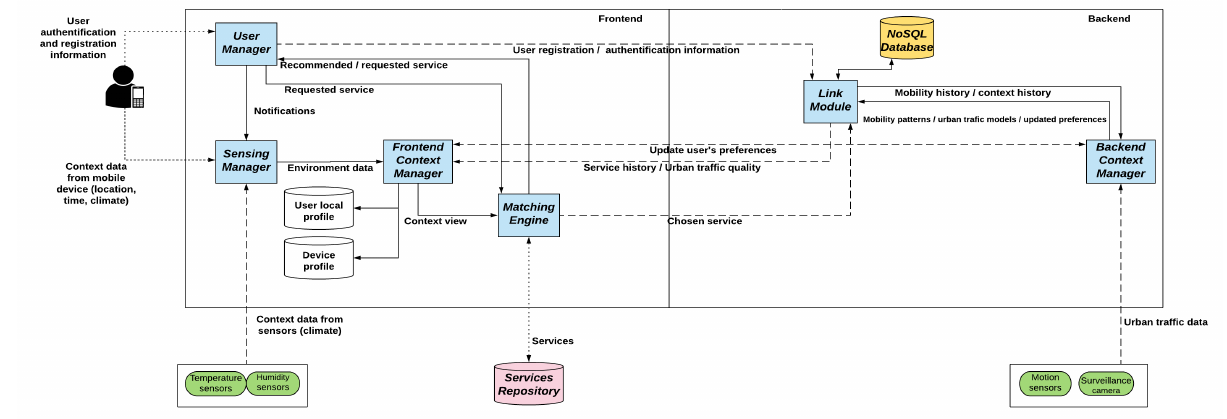
Figure 4. Overview of a mobile service recommendation architecture in smart